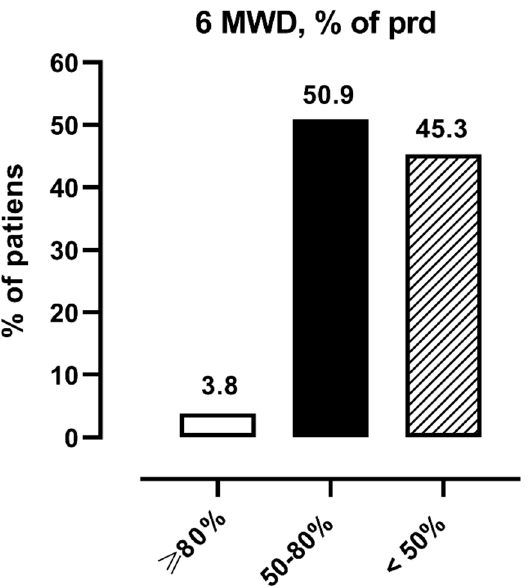
Figure 2. Distribution of patients according to level of performance at 6MWD: normal ( ≥ 80%pred.), moderately reduced (50–80%pred.) and severely reduced (<50%pred.). Legend: 6MWD = 6 min walking distance.